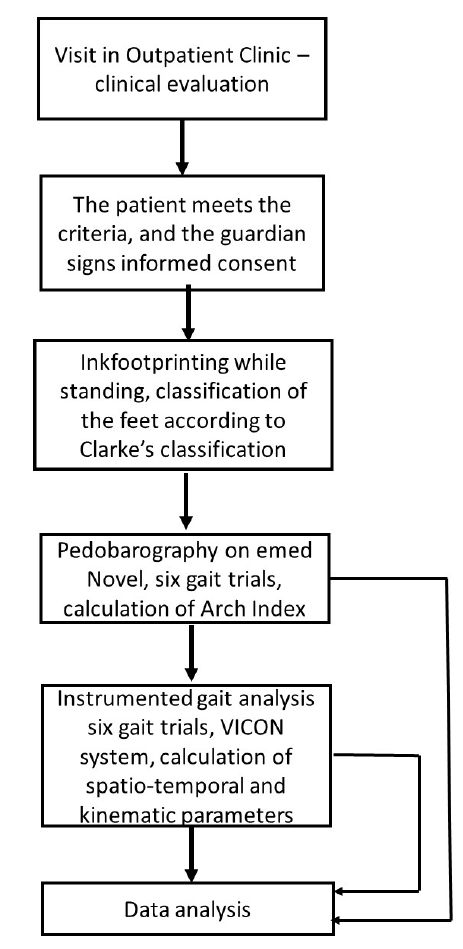
Figure 1. Flow chart of the study.